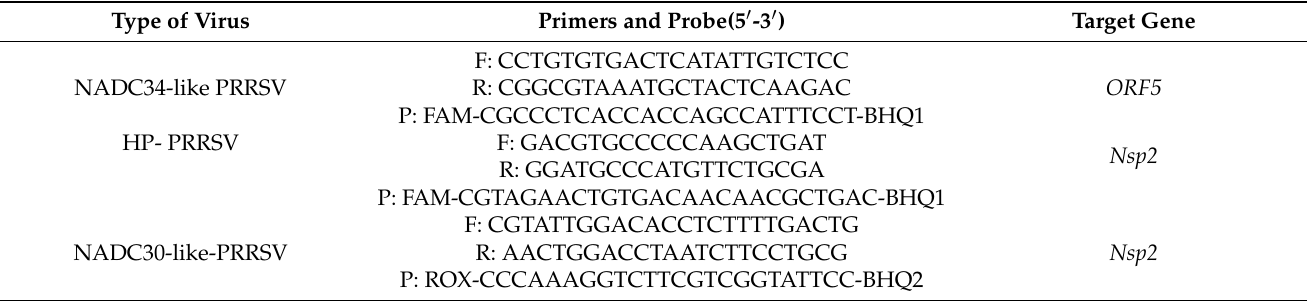
Table 1. Information on the RT-qPCR